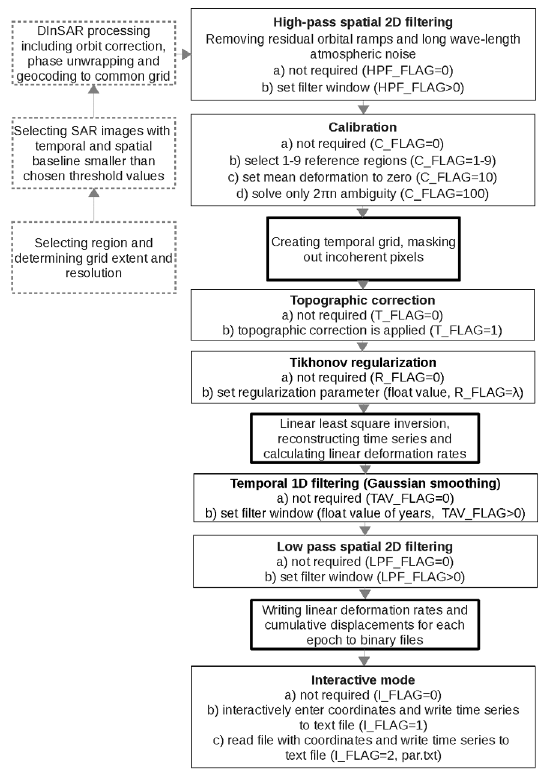
Figure 5. Flowchart diagram of MSBAS processing